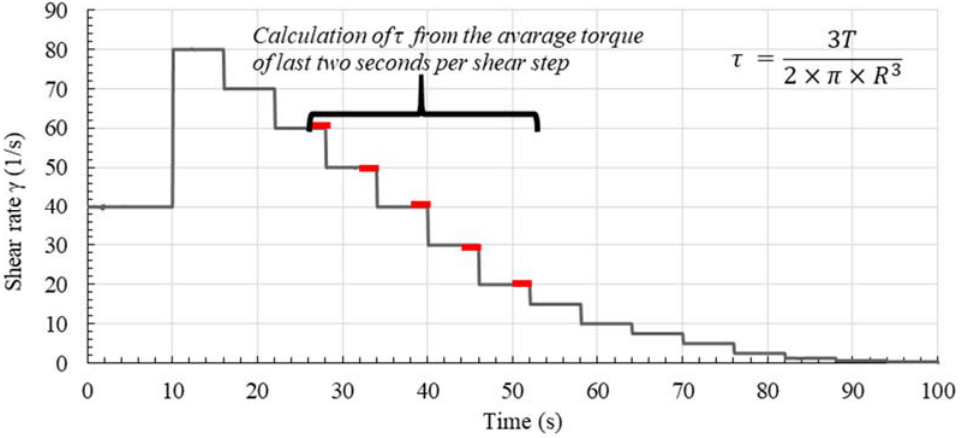
Figure 3. Shear protocol for rheometric measurements.